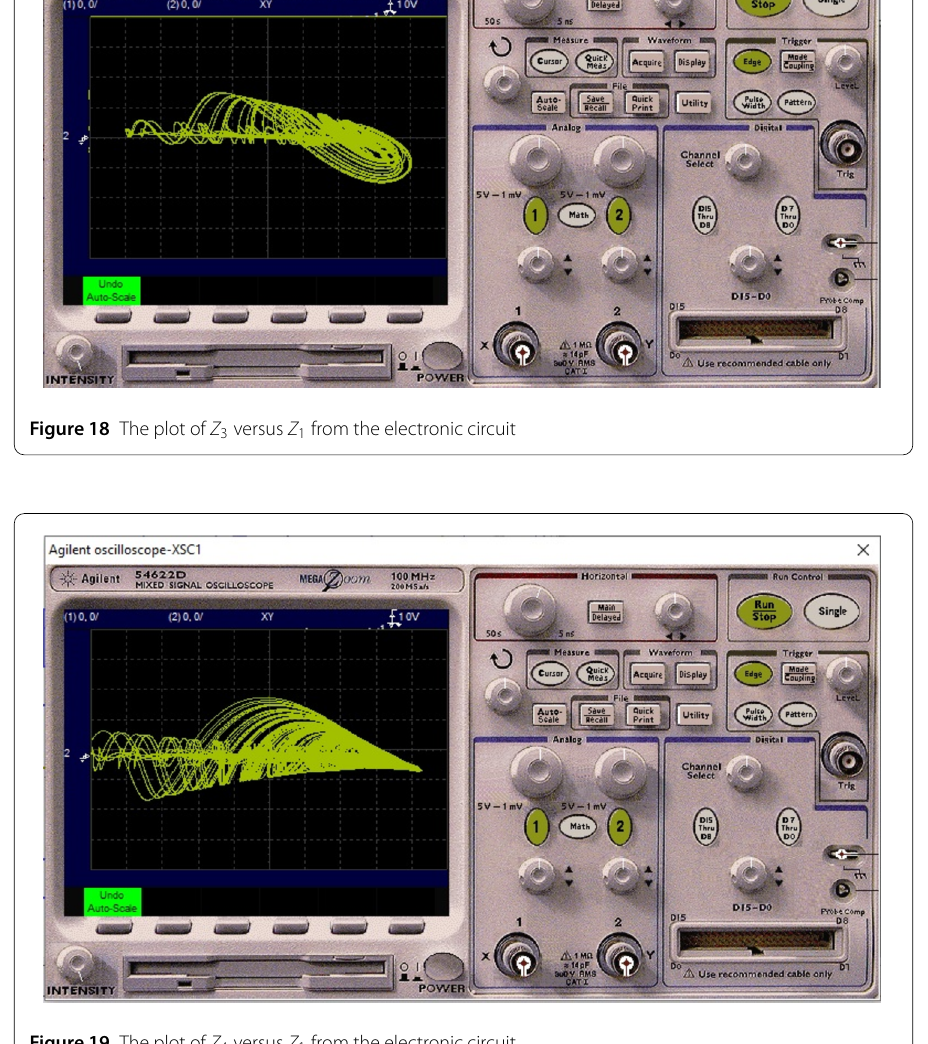
Figure 19 The plot of Z 4 versus Z 1 from the electronic